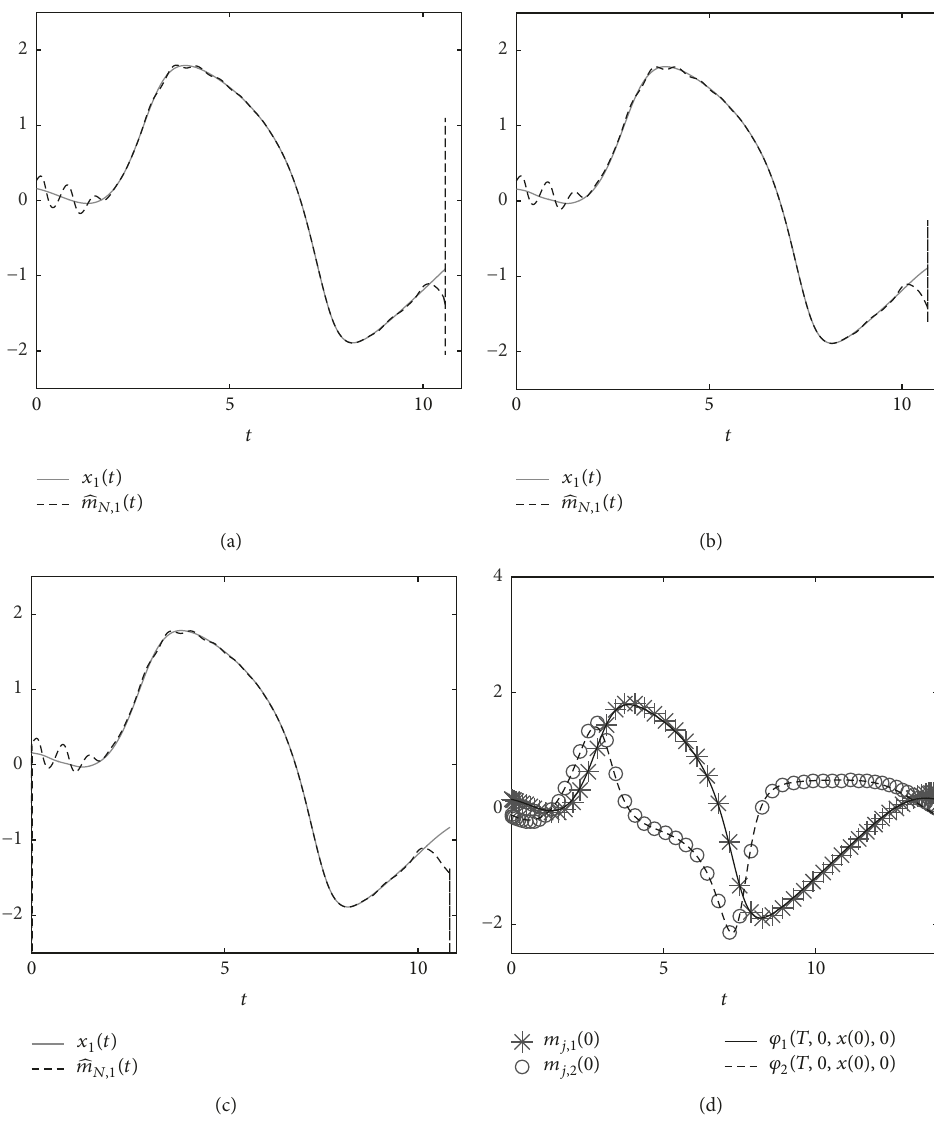
Figure 13: Time-series of a trajectory when applying the aPBC with 𝑁 = 62 and (a) 𝑘 = 0 and 𝑘 𝑜 = 10 ; (b) 𝑘 = 0.25 and 𝑘 𝑜 = 10 ; (c) 𝑘 = 0.25 and 𝑘 𝑜 = 1000 ; (d) time-series of 𝜑(𝑇,0, 𝑥(0),0) and the initial value of the predicted states 𝑚 𝑗 (0)